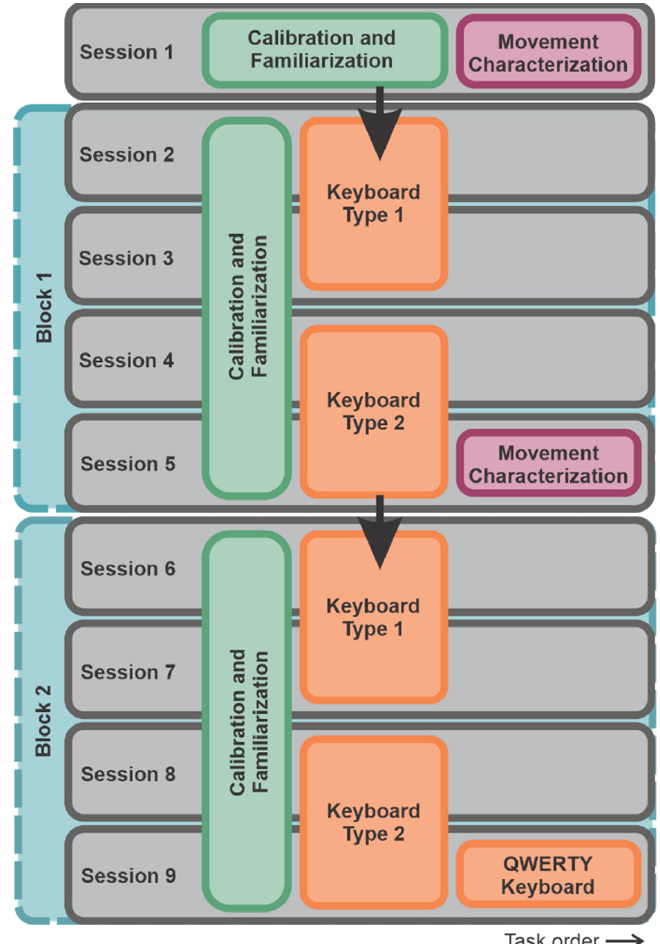
Figure 3. Organization of the 9-session study.